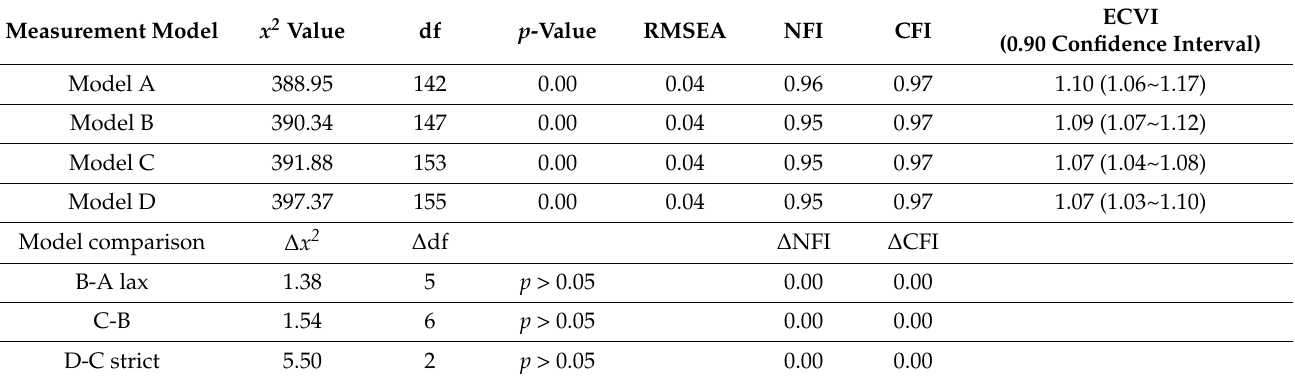
Table 9. Recreational Sport Well-being Model Cross-Validation